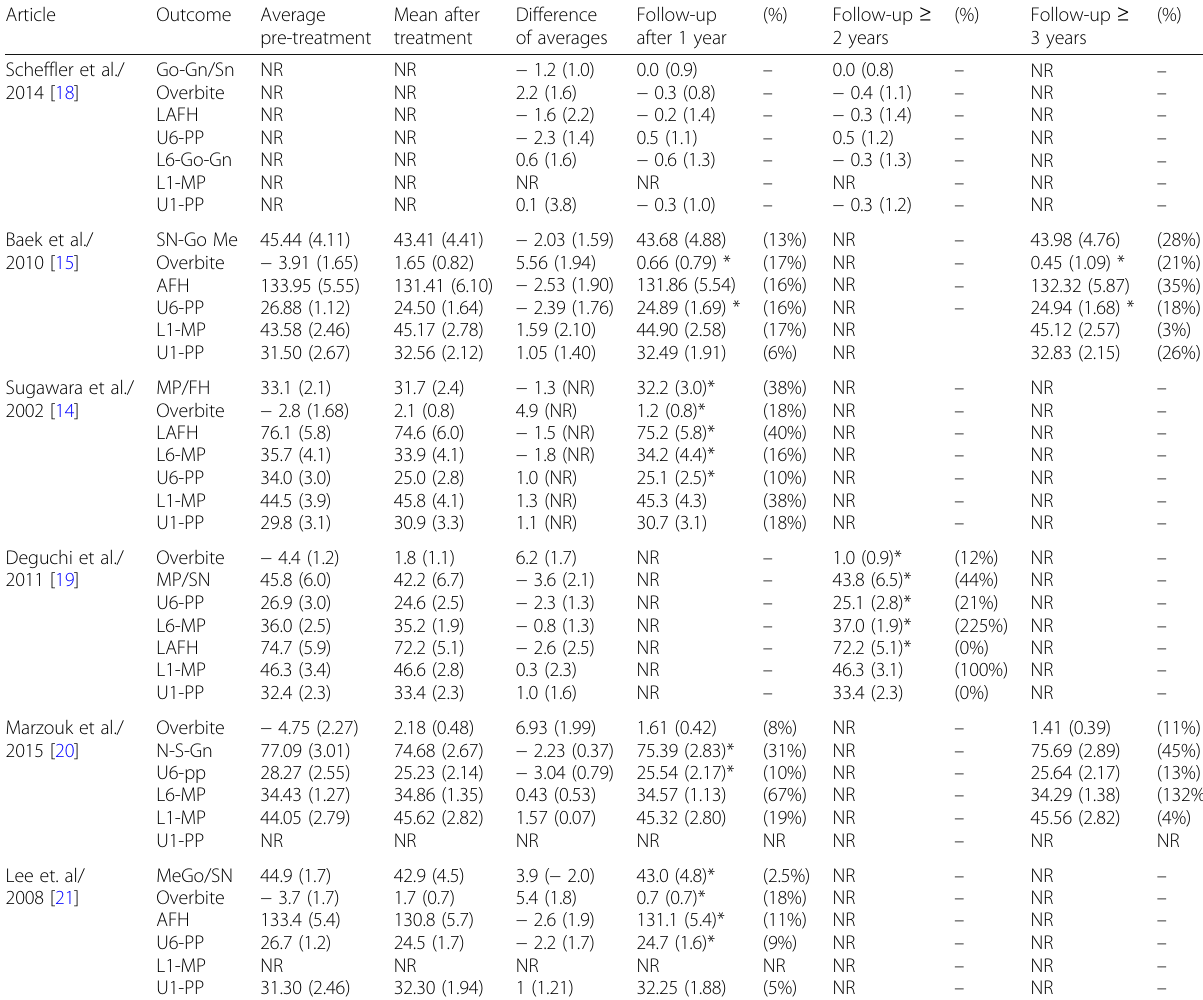
Table 4 Cephalometric measurements extracted from selected